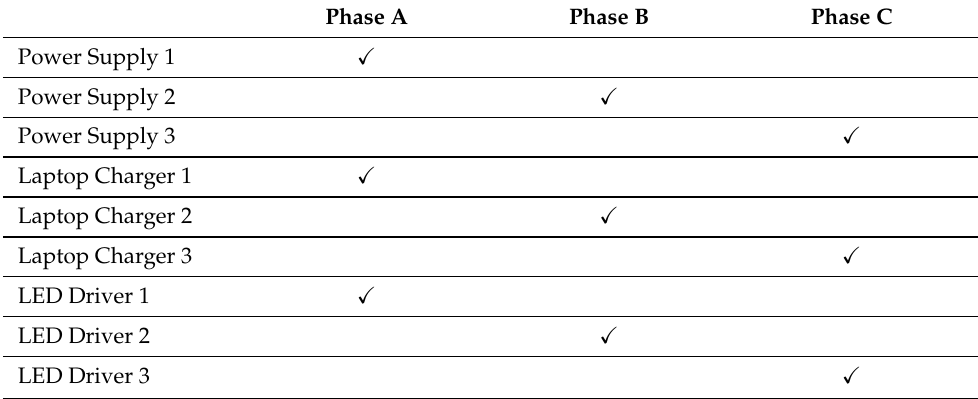
Table 1. Device configurations for AC Scenarios 1 and 2.